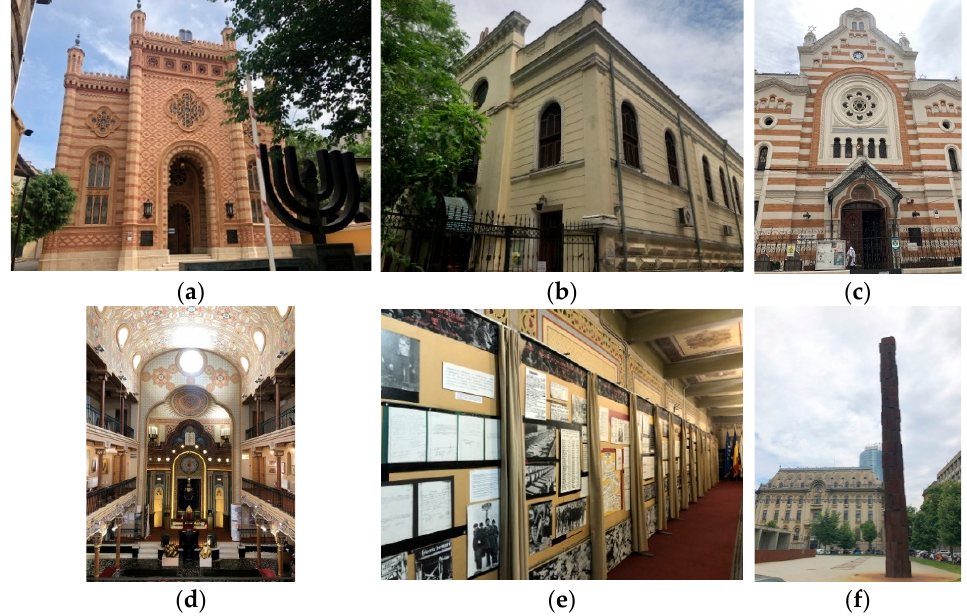
Figure 4. ( a ) Choral Temple and the menorah monument; ( b ) Great Synagogue; ( c ) United